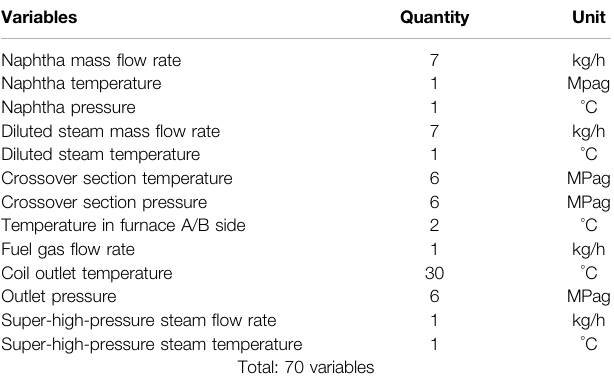
TABLE 1 | Process variable information of the cracking